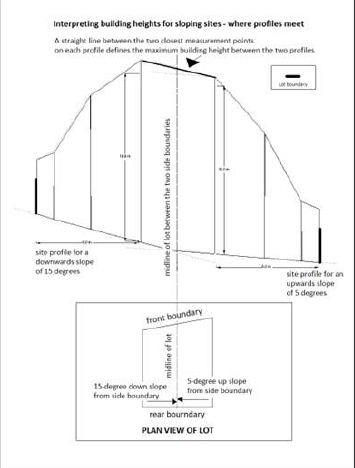
Figure 1. Interpreting building heights for sloping sites.